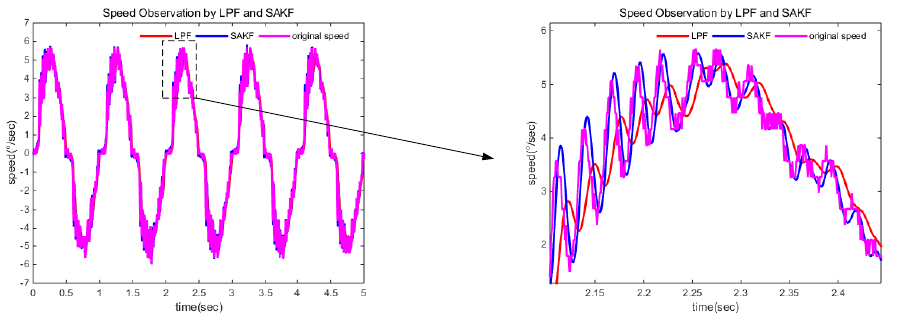
Figure 8. Comparison of speed observation by LPF and SAKF.